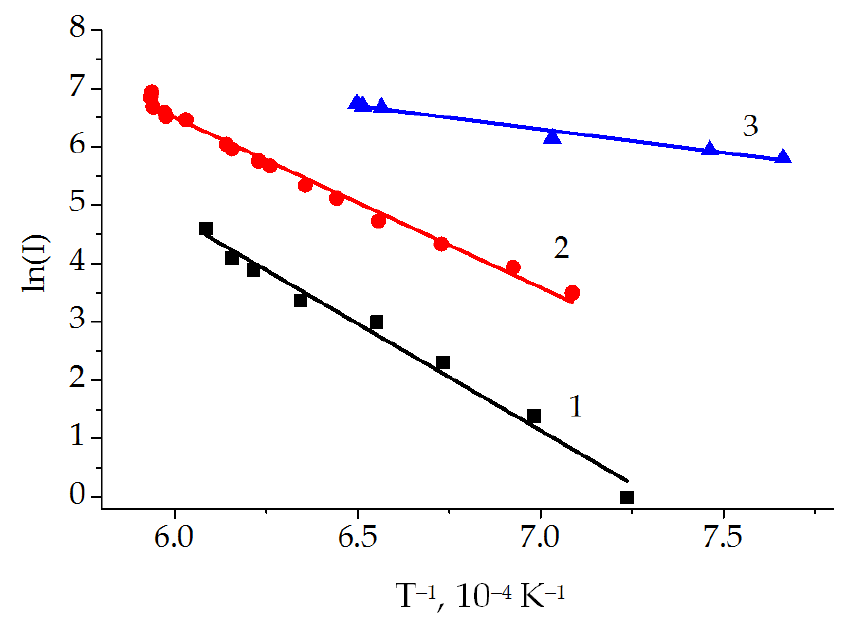
(cid:16) (cid:17) 1 for composites of different compositions: (1) com- T for composites of different compositions: (1) 